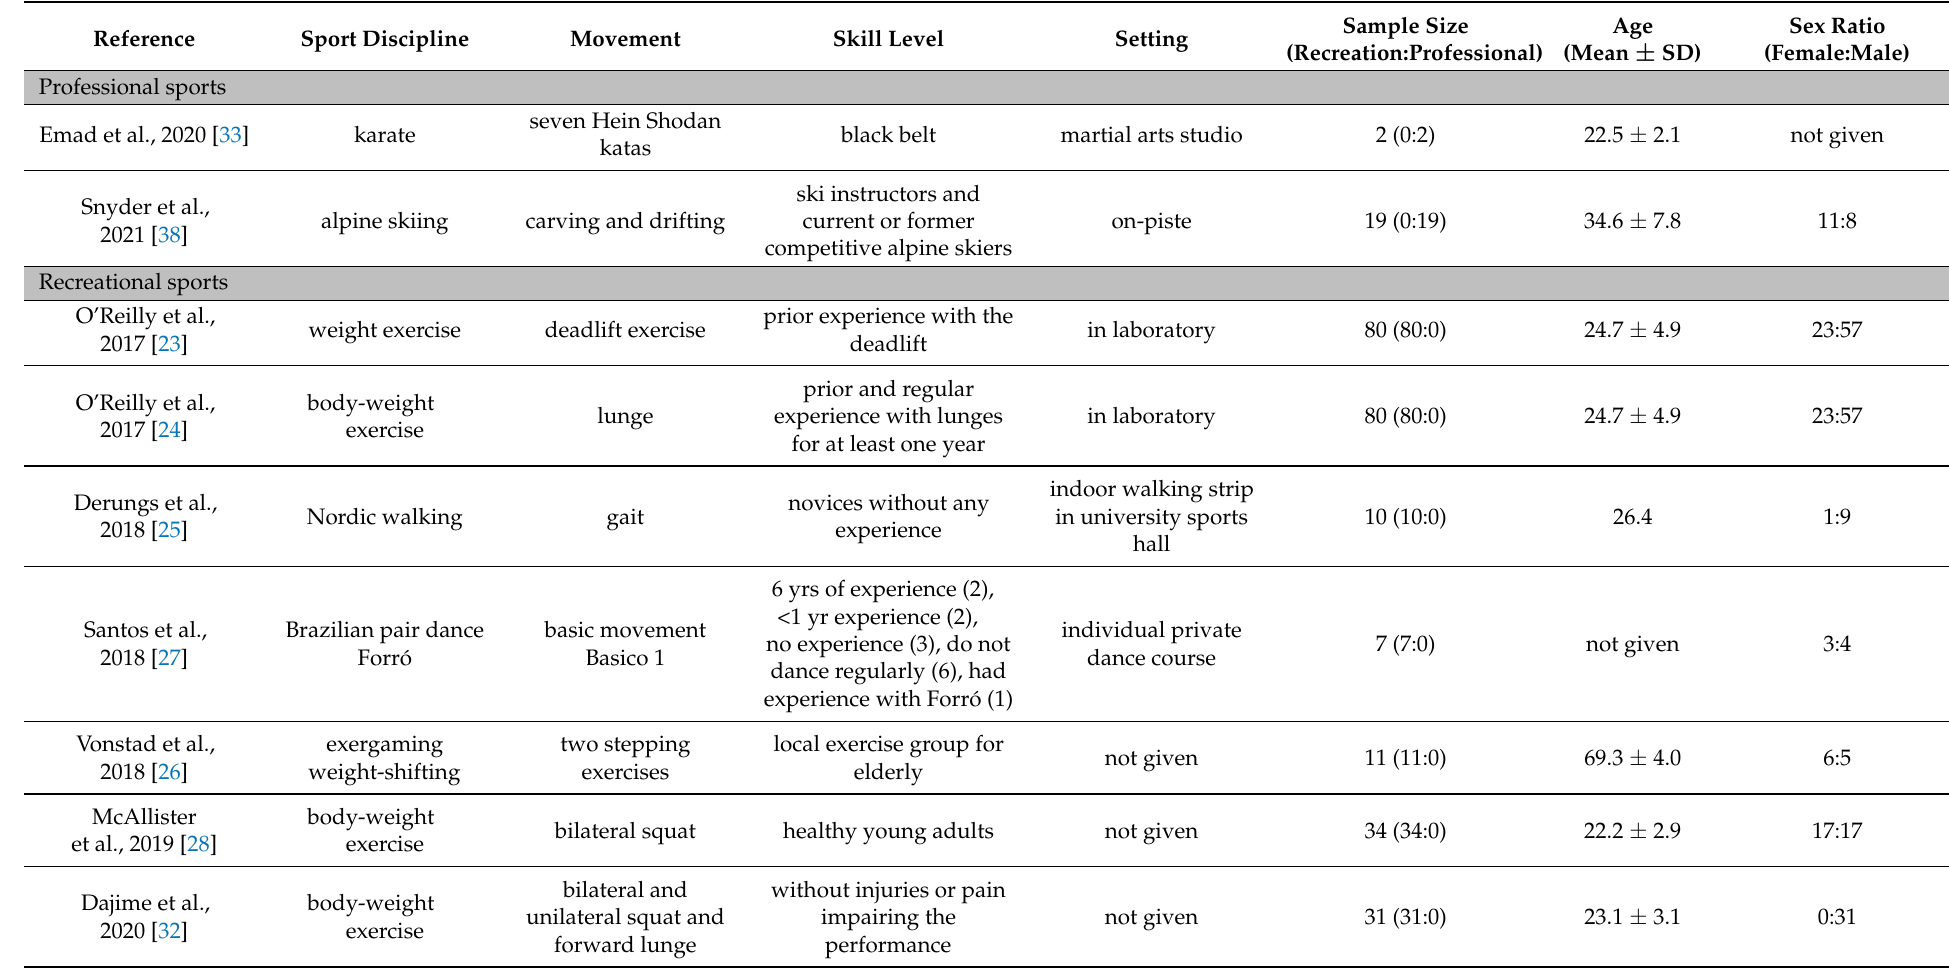
Table 1. Sport disciplines, types of movements, reported skill level and setting in which the studies were conducted ( n =